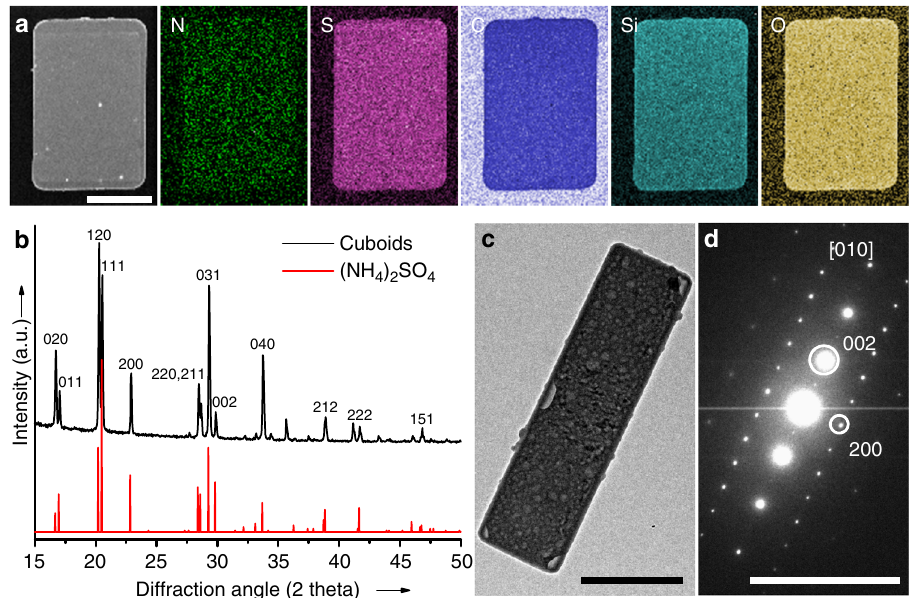
Fig. 2 Characterization of the structure and composition of colloidal cuboids. a Annular dark fi eld TEM image and TEM-EDS maps of a cuboidal particle ( L = 5100 nm, W = 3400nm, T = 80 nm). b XRD pattern, c TEM image, and d corresponding selected area electron diffraction pattern of a cuboid ( L = 3200 nm, W = 880 nm, T = 180 nm). Scale bars, 2 μ m in ( a ), 1 μ m in ( c ), and 10 nm − 1 in ( d transform infrared spectroscopy (FT-IR) spectra of cuboids electron microscope (TEM) image and energy-dispersive X-ray before and after removing the cores also suggest the presence of spectrometer (EDS) maps of a typical particle indicate a uniform (NH 4 ) 2 SO 4 and silica components in particles (Supplementary distribution of N, S, C, Si, and O, but no presence of Fe across the whole particle (Fig. 2a and Supplementary Fig. 6). Fourier Fig. 7). The formation of pure (NH 4 ) 2 SO 4 crystal was further